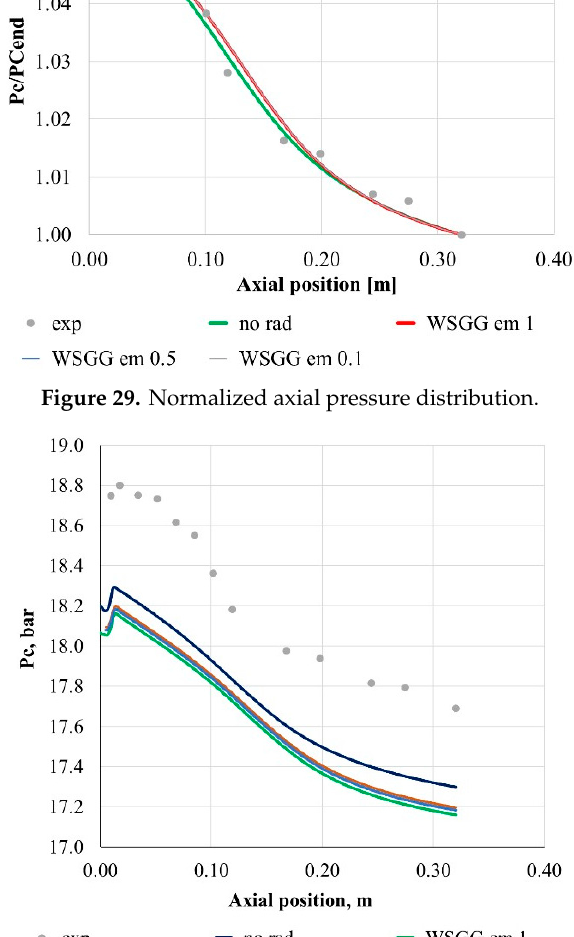
Figure 31. Segment average heat flux distribution. Table 4. Influence of radiation and wall emissivity. Criterion